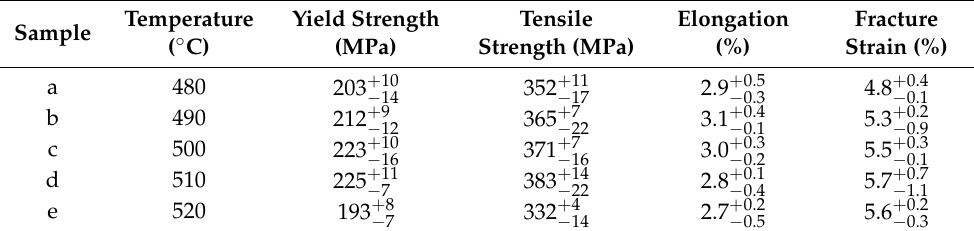
Figure 4. The mechanical properties of Al-13Si-5Cu-2Ni alloy solution treated at different tempera- tures for 8 h and 165 ◦ C aging for 10 h: ( a ) the engineering stress–strain curves and ( b ) bar graph of tensile strength and fracture strain. Table 3. Data of the tensile strength and fracture strain of the Al-13Si-5Cu-2Ni alloy solution treated at different temperatures for 8 h and 165 ◦ C aging for 10